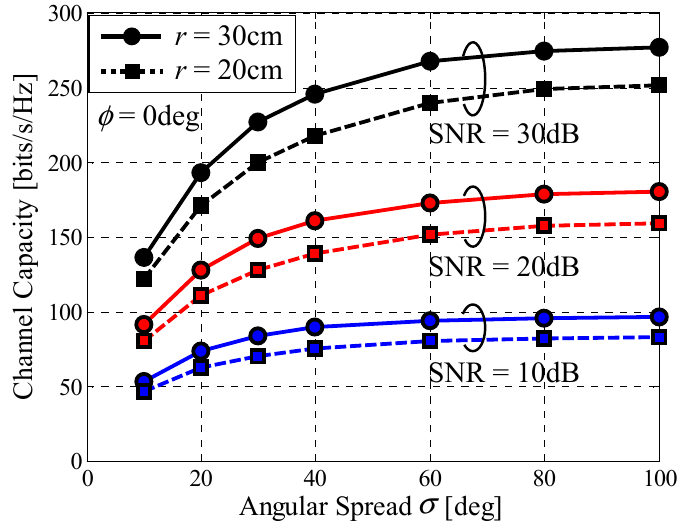
Figure 15. Channel capacity vs. the angular power spread.